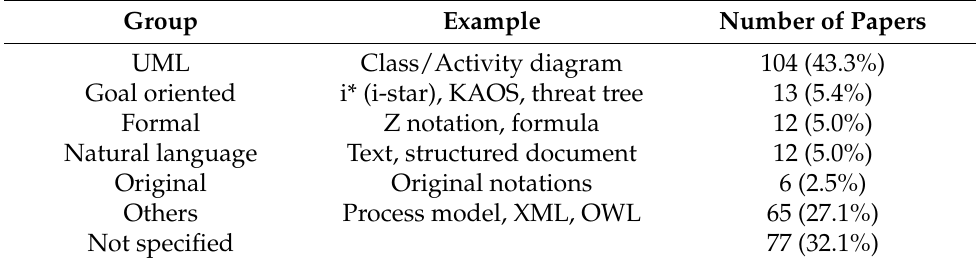
Table 4. Pattern modeling